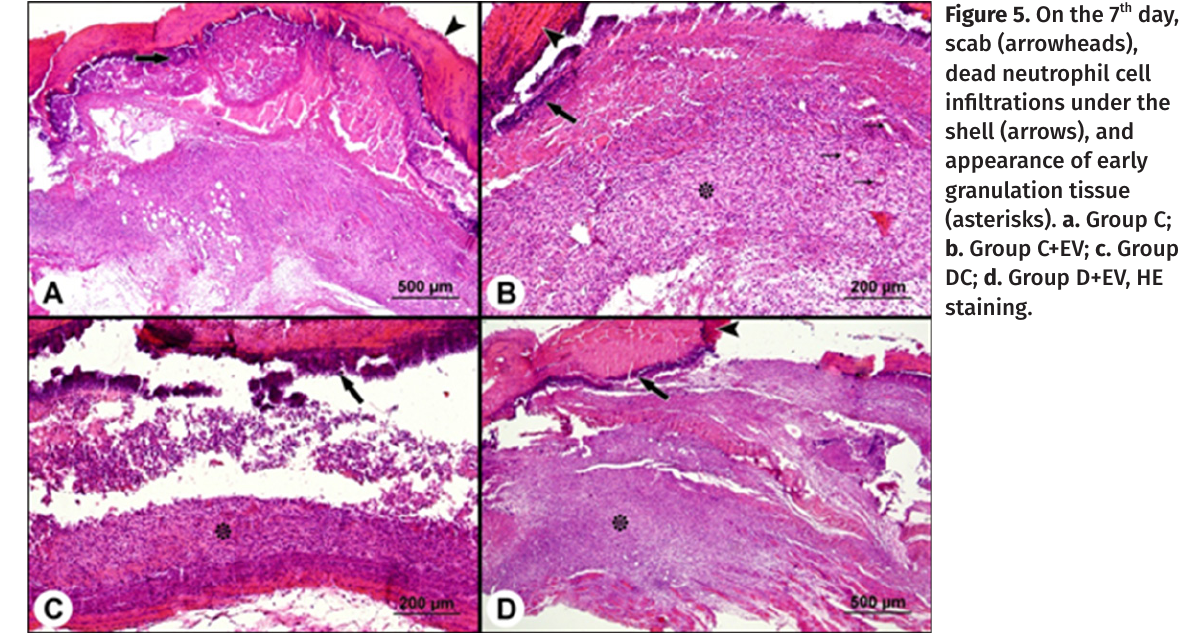
Figure 5. On the 7 th day, scab (arrowheads), dead neutrophil cell infiltrations under the shell (arrows), and appearance of early granulation tissue (asterisks). a. Group C; b. Group C+EV; c. Group DC; d. Group D+EV, HE